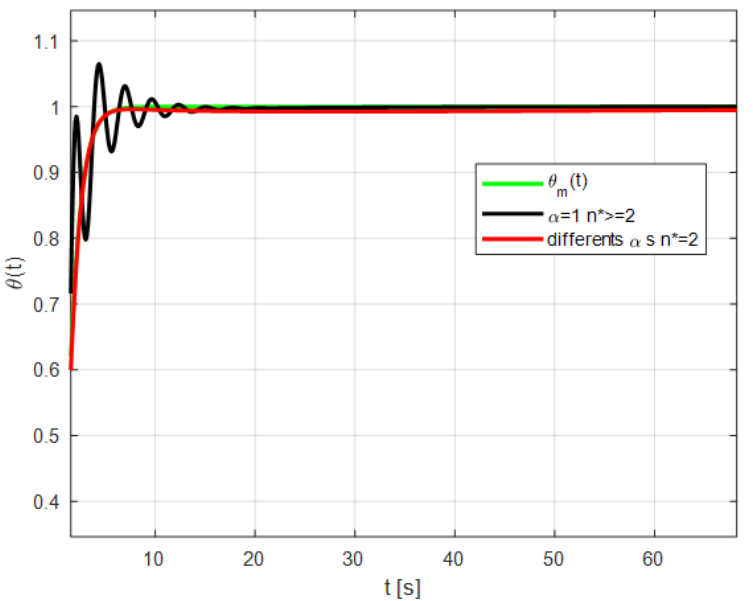
Figure 16. Evolution of the pitch angle θ (t) with the generalized IO-DMRAC (black color) and FO-DMRAC (red color). The reference is shown in green (unit step).